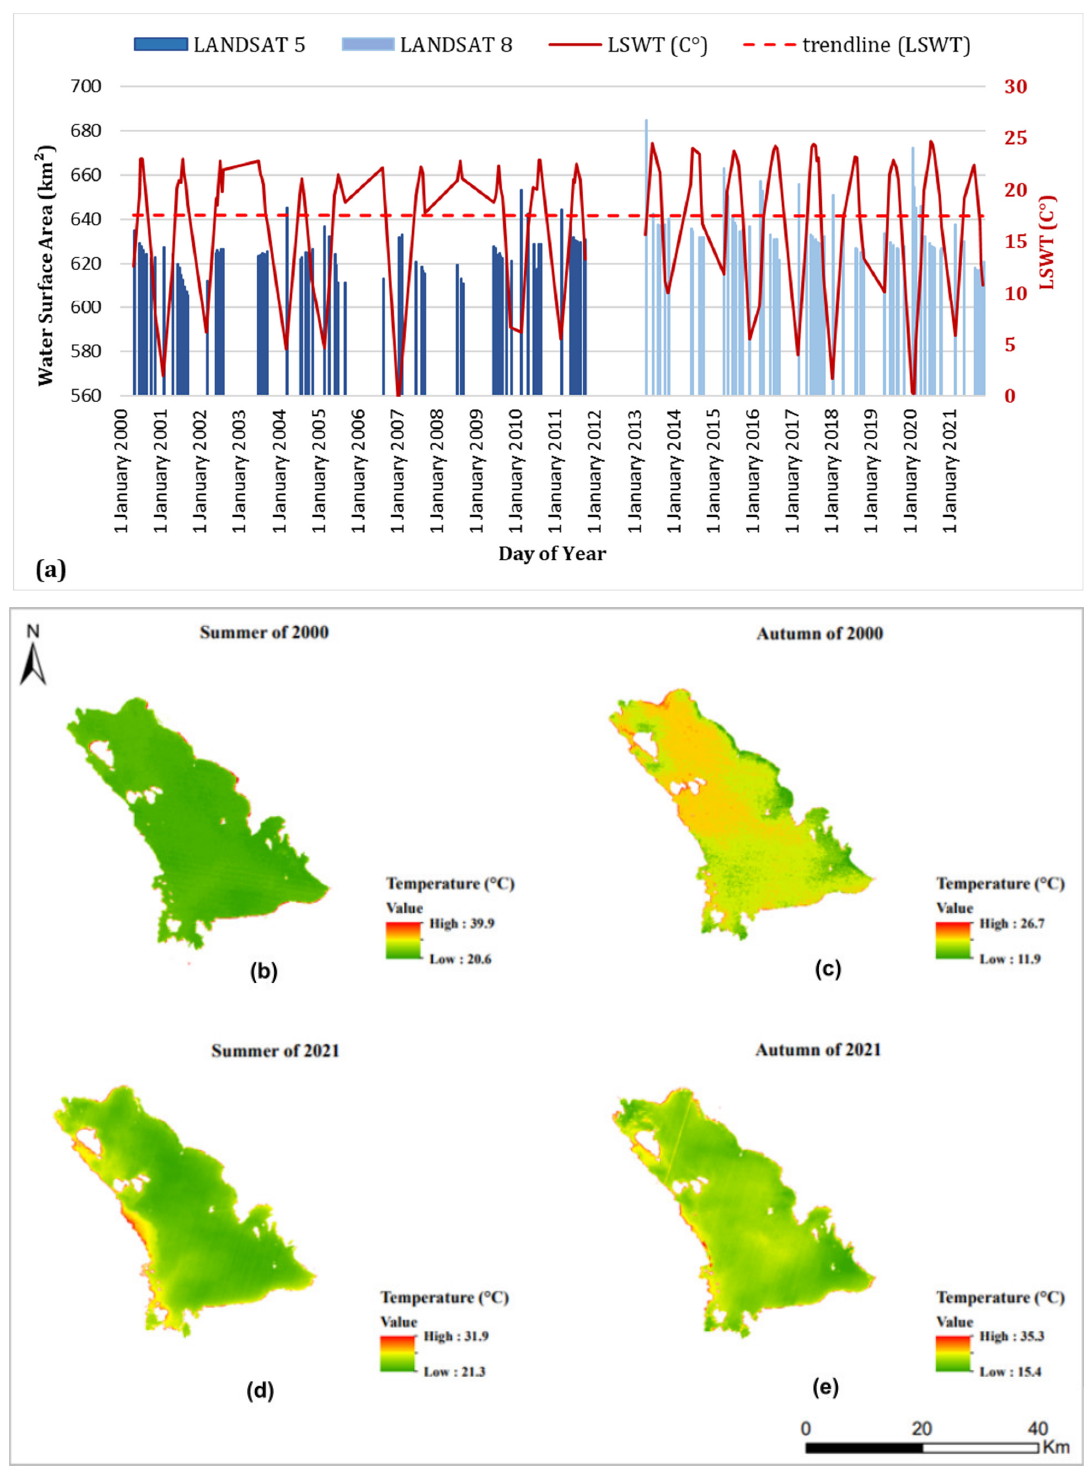
Figure 14. ( a ) The temporal changes in water extent of Beysehir Lake with the LSWT variable. The spatial changes of water surface area with LSWT for: ( b ) summer 2000, ( c ) autumn 2000, ( d ) summer 2021, and ( e ) autumn 2021. Since there was no ground-based LST station in the region, we compared the average LSWT time series with MODIS LST for each lake. Figure 15 represents the scatter plot and correlation values between LSWT and MODIS LST for all three lakes. The correlation re- sults were above 0.93, revealing that the obtained LSWT values are highly compatible with MODIS LST data.